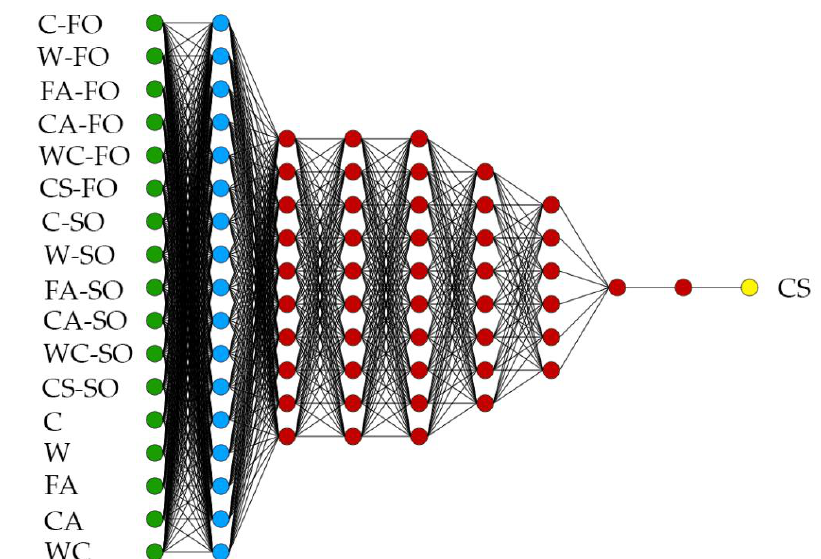
Figure 5. Final architecture of deep neural network (DNN) that was used. The figure shows the DNN architecture, which includes principal components (blue), perceptron neurons (red), and scaling and unscaling layers. The scaling neurons are green, and unscaling neurons are yellow. Abbreviations: